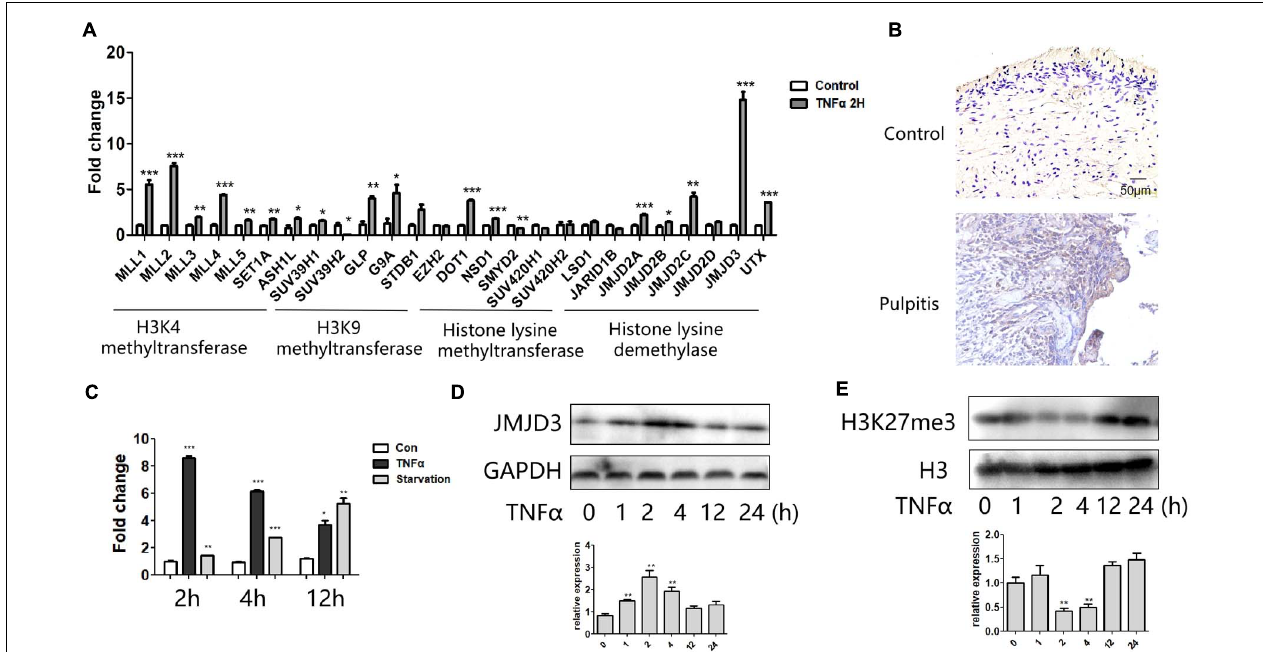
FIGURE 2 | JMJD3 expression was most highly induced in response to TNF α stimulation. (A) QPCR analysis of several groups of histone lysine methyltransferase and demethylases in HDPCs with 2 h stimulation of TNF α . (B) Immumohistochemical staining of JMJD3 in healthy control pulp tissue (up) and pulpitis tissue (low). (C) QPCR analysis of JMJD3 expression in HDPCs with TNF α or starvation stimulation at indicated time. (D,E) Western blot analysis of JMJD3 (D) and H3K27me3 (E) in HDPCs with TNF α stimulation. Below was the relative quantification of the bands. ∗∗ P < 0.01, ∗∗∗ P < 0.001.